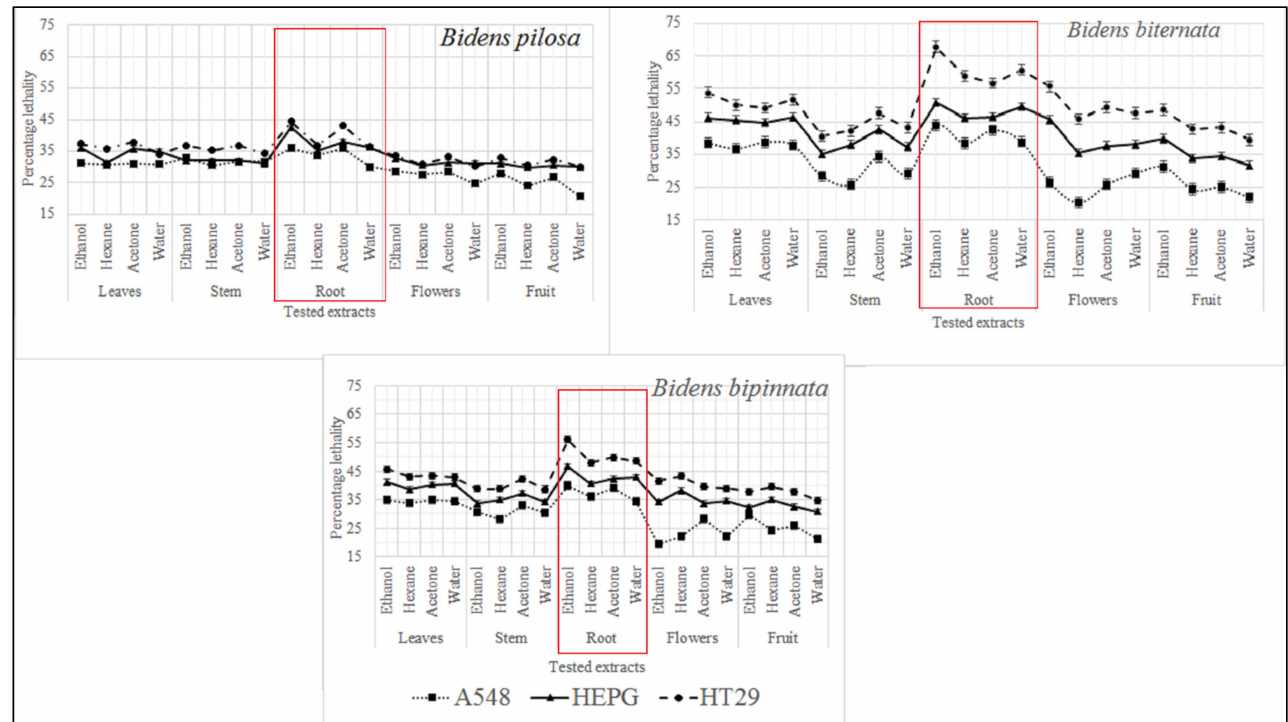
Figure 2. Cytotoxic activity of selected plants of the genus Bidens against cervical cancer cells (HeLa), hepatocellular carcinoma (HepG), and adenocarcinoma human alveolar basal epithelial cells